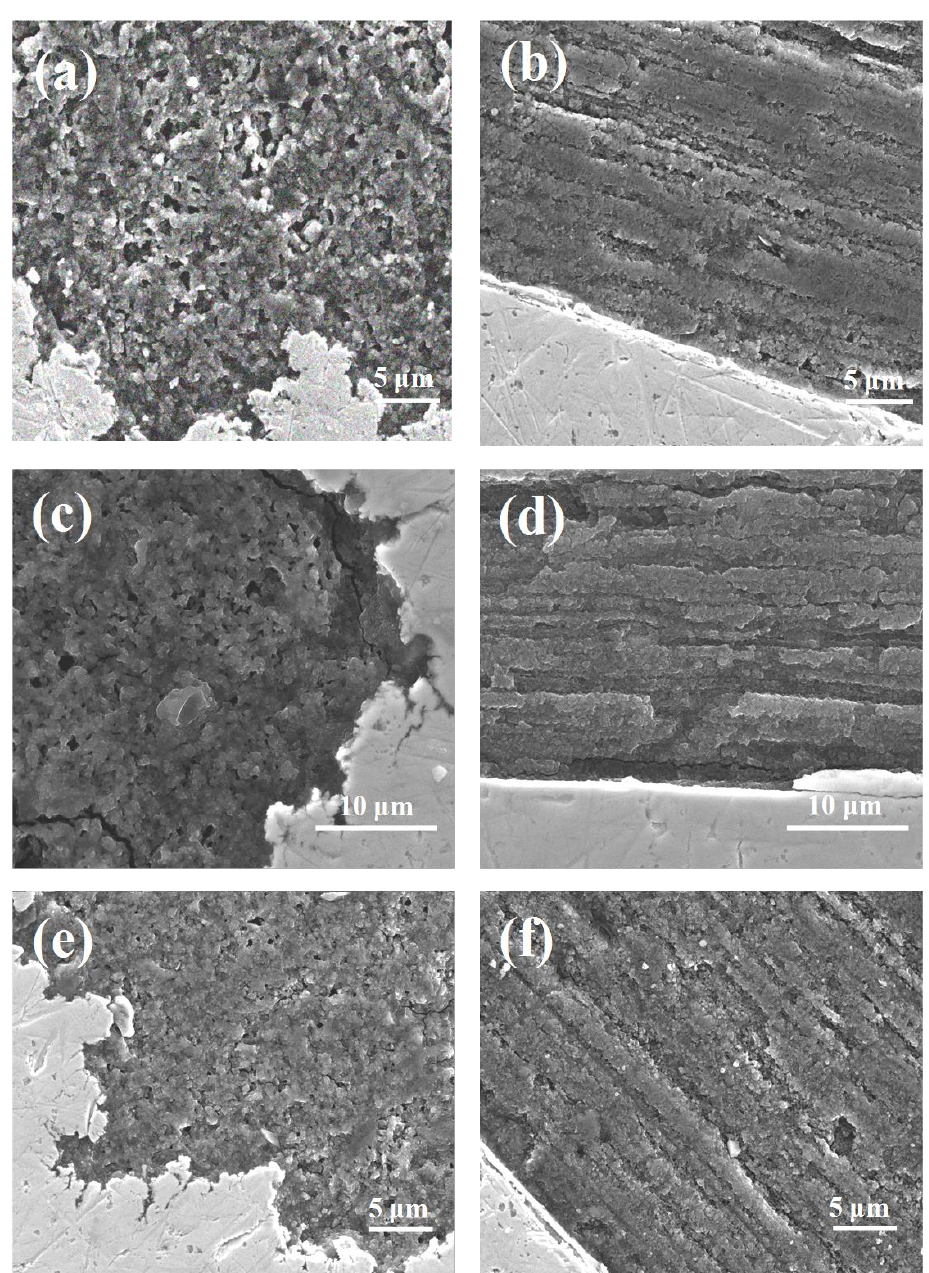
Figure 1. SEM images of undoped MgB 2 wires with a diameter of 0.83 mm: ( a ) cross-section and ( b ) longitudinal section for sample A (0.1 MPa and 700 ◦ C), ( c ) cross-section and ( d ) longitudinal section for sample B (1 GPa and 700 ◦ C), and ( e ) cross-section and ( f ) longitudinal section for sample C (1 GPa and 725 ◦ C). The metal sheath is the Nb